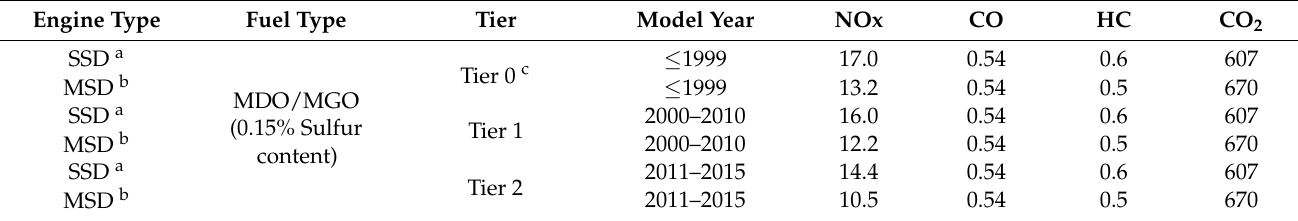
Table 5. Emission factors for the main engine,